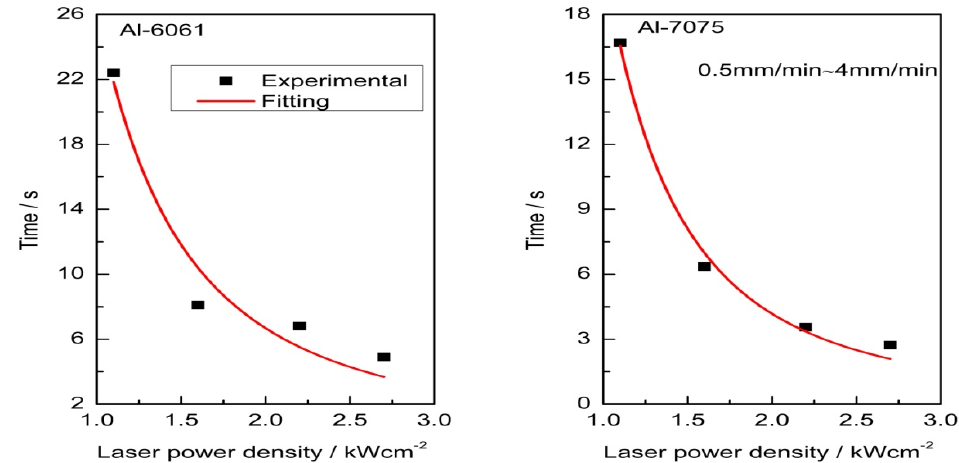
Figure 4. Fitting results of the failure time of Al-6061 and Al-7075 type specimens against laser power density.